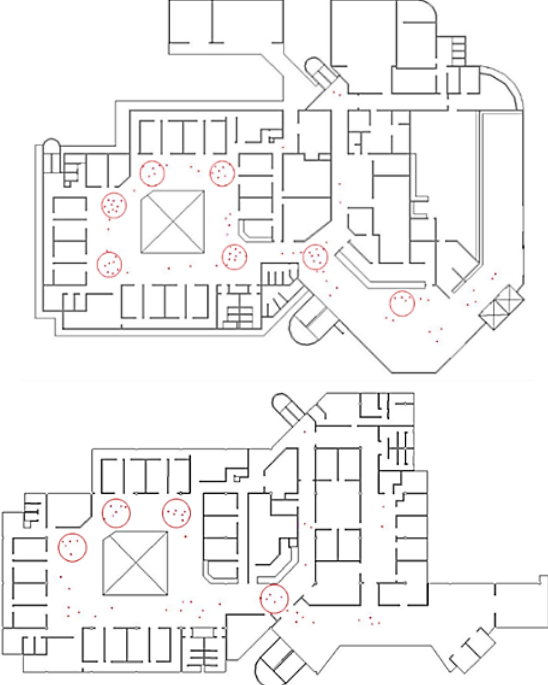
Figure 13. Illustration of the location of the map calls mapped on the building layout of the 2nd VRE.